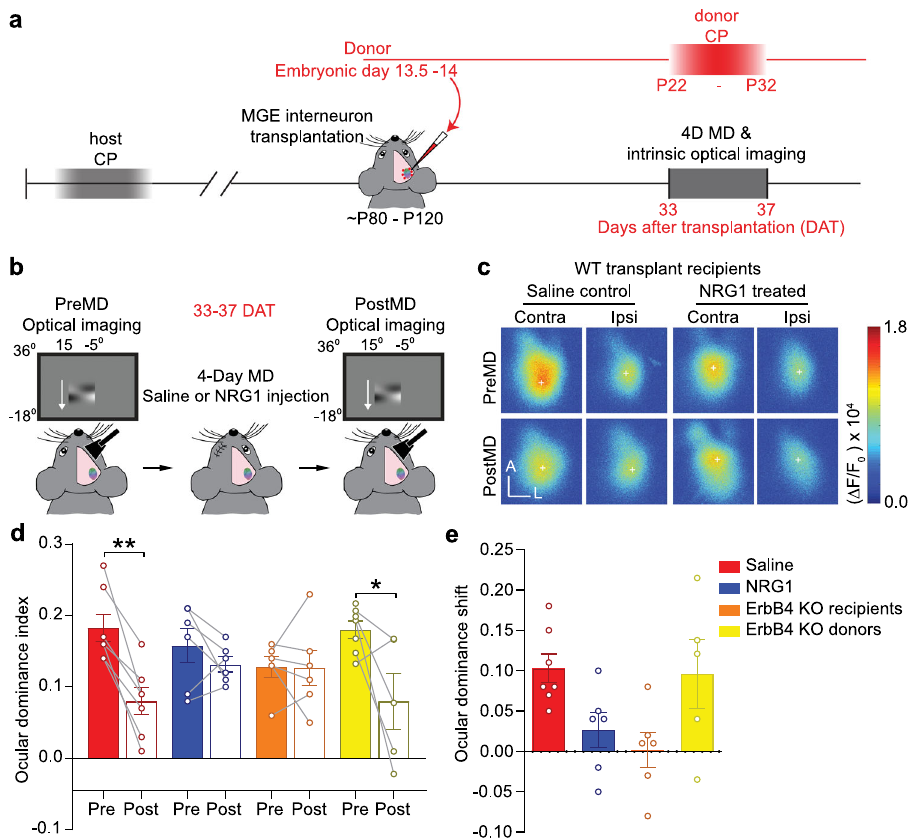
Fig. 7 Transplant-induced ODP depends on NRG1/ErbB4 signaling. a Experimental timeline. b Intrinsic optical imaging was performed to measure ocular dominance plasticity (ODP) in adult transplant recipients around 33 – 35 days after transplantation (DAT). The wild-type adult recipients received